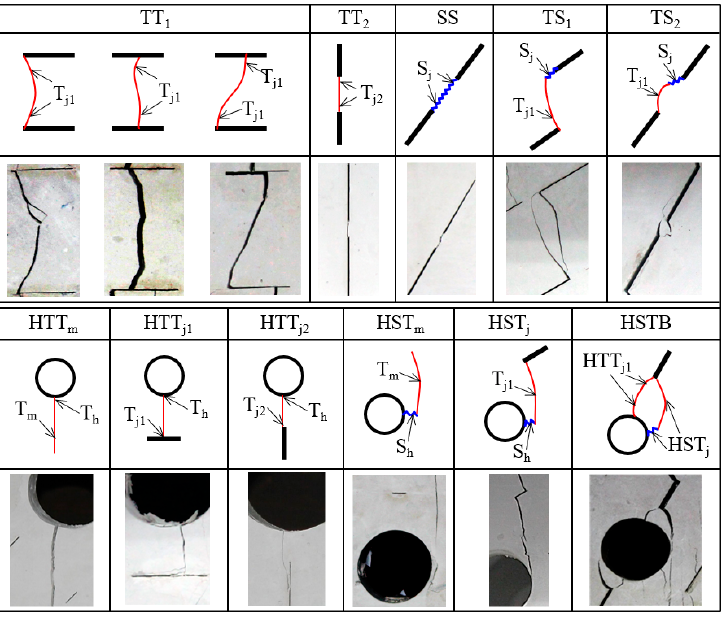
Figure 7. Observed crack coalescence types between the joints and between the hole and the matrix or joint.